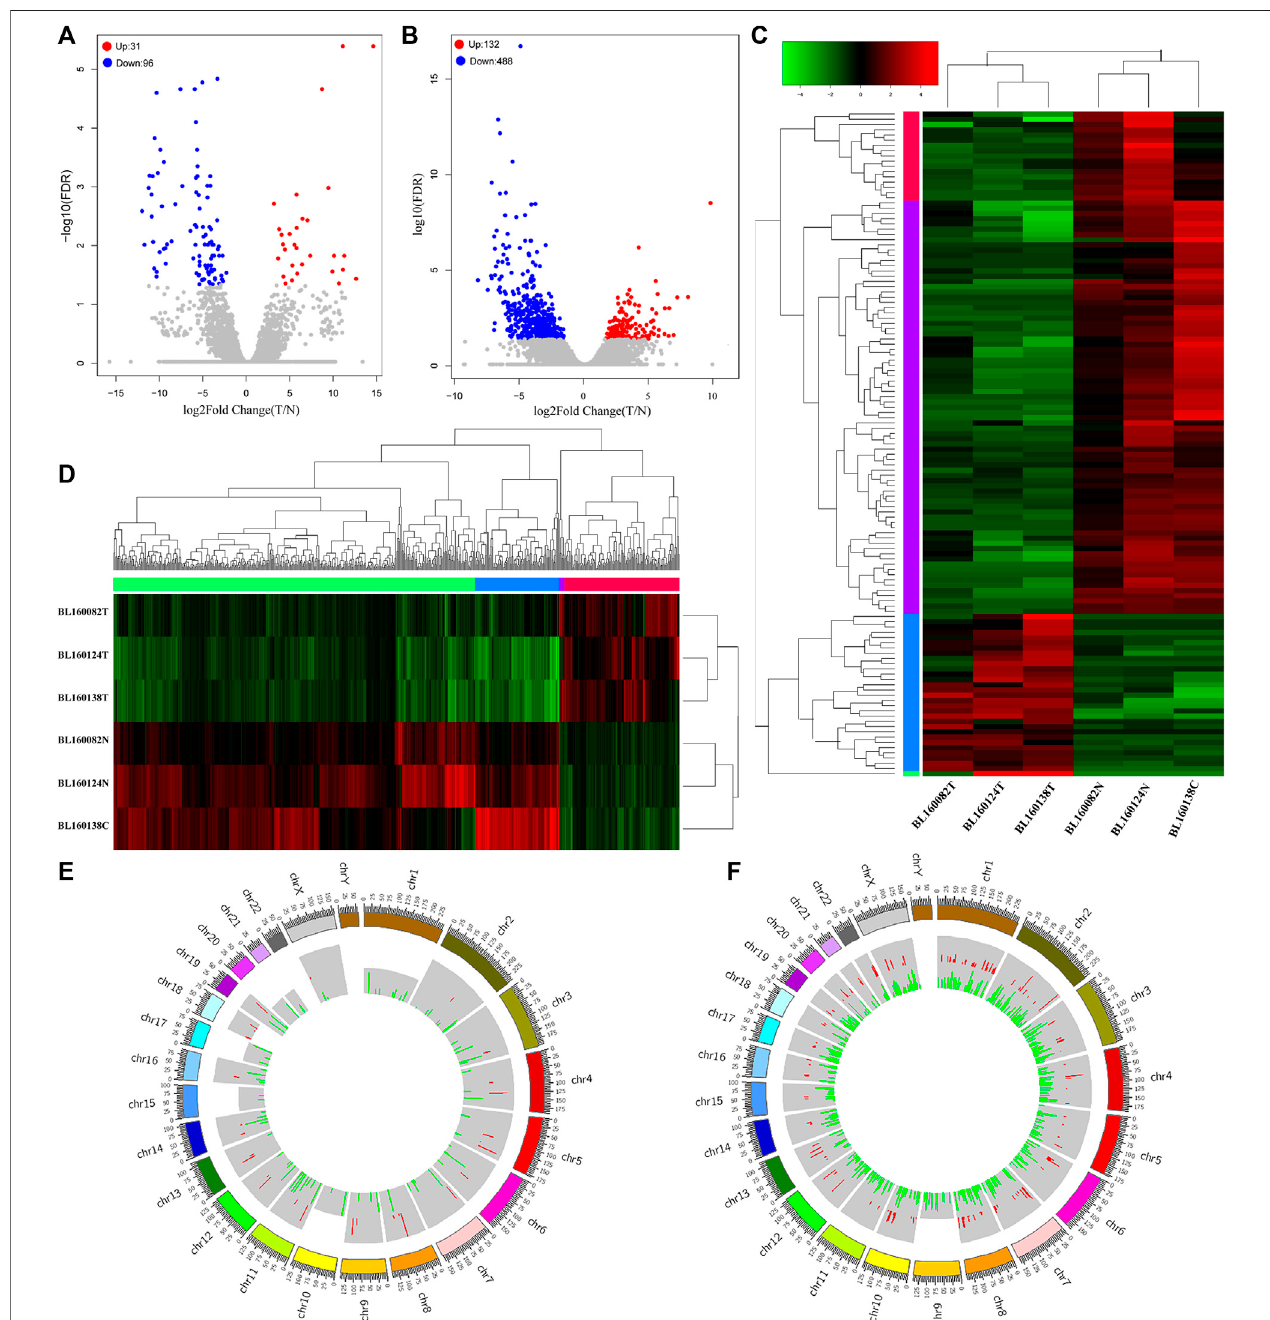
FIGURE 2 | (A) The volcano plot showed that a total of 31 upregulated lncRNAs and 96 downregulated lncRNAs were screened out from bladder cancer sequencing data. Blue dot represented downregulated lncRNAs. Red dot represented upregulated lncRNAs. Gray dot represented normal lncRNAs. (B) The volcano plot showed that a total of 132 upregulated mRNAs and 488 downregulated mRNAs were screened out from bladder cancer sequencing data. Blue dot represented downregulated mRNAs. Red dot represented upregulated mRNAs. Gray dot represented normal mRNAs. (C) Heatmap of 127 differentially expressed lncRNAs. The diagram presentsthe result ofa two-way hierarchical clustering of all the differentially expressed lncRNAs and samples. (D) Heatmap of 620 differentially expressed mRNAs. The diagram presents the result of a two-way hierarchical clustering of all the differentially expressed mRNAs and samples. (E) Circos histograms showed the distribution of differentially expressed lncRNAs on chromosomes (hg38 as reference). The red color of the inner circle indicates upregulated lncRNAs, and green indicates downregulated lncRNAs. The colored blocks in the outer circle represent different chromosomes, and the numbers on the outside represent the position ruler ofchromosomes. (F) CircoshistogramsshowedthedistributionofdifferentiallyexpressedmRNAsonchromosomes(hg38asreference).Theredcoloroftheinnercircle indicatesupregulatedmRNAs,andgreenindicatesdownregulatedmRNAs.Thecoloredblocksintheoutercirclerepresentdifferentchromosomes,andthenumberson the outside represent the position ruler of chromosomes. BL160082T, BL160124T and BL160138T were bladder cancer tissue samples, while BL160082N, BL160124N and BL160138C were corresponding adjacent tissues samples.